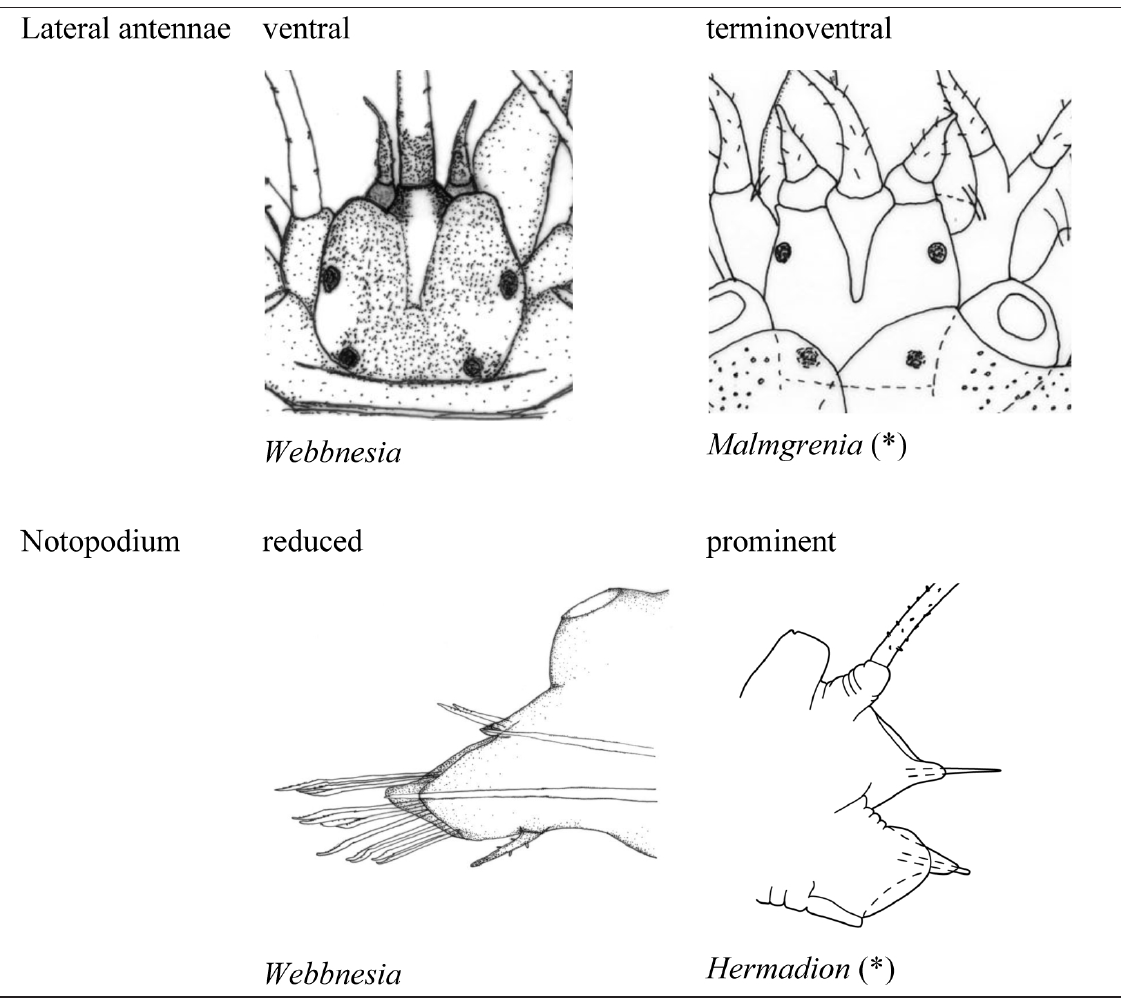
Table 3. Comparison of important generic characters. (*) Prostomium of Malmgrenia bicki Barnich, Dietrich, Hager & Fiege, 2017 (modified from Barnich et al . 2017); parapodium of Hermadion magalhaensi Kinberg, 1856 (modified from Bock et al .